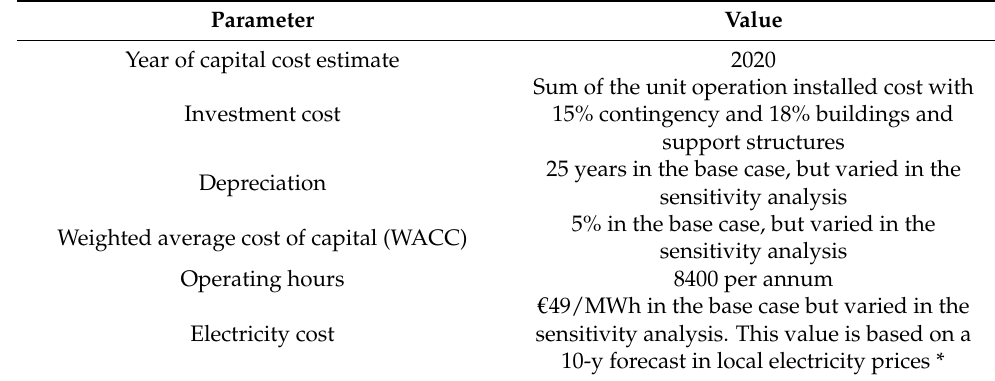
Table 1. Assumptions used for economic calculations. Parameter Value Year of capital cost estimate Sum of the unit operation installed cost with Investment cost 15% contingency and 18% buildings and support structures 25 years in the base case, but varied in the Depreciation sensitivity analysis 5% in the base case, but varied in the Weighted average cost of capital (WACC) sensitivity analysis Operating hours 8400 per annum Electricity